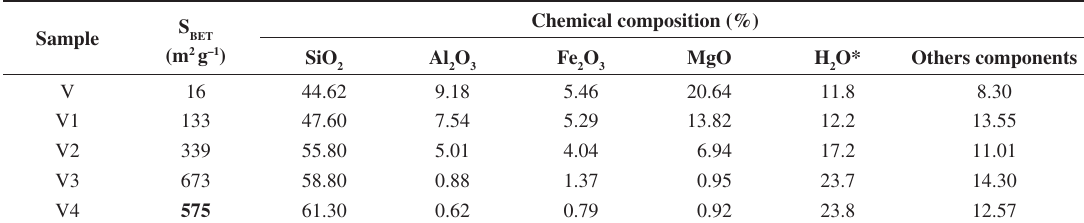
Table 1. Chemical composition and specific surface area (S